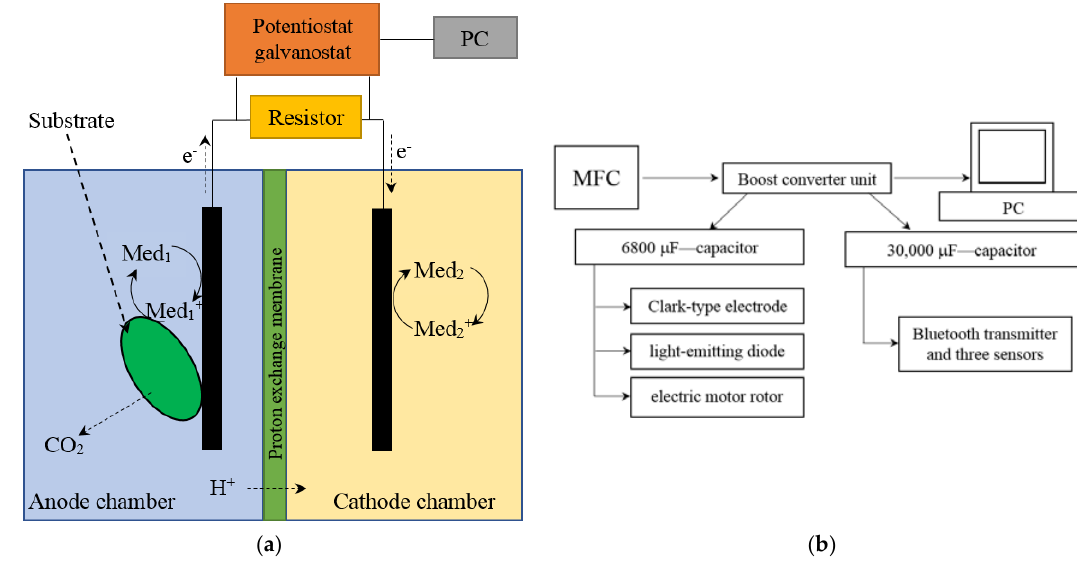
Figure 1. Scheme for the MFC and its external connections ( a ); block diagram for converter accumulation of energy ( b ).